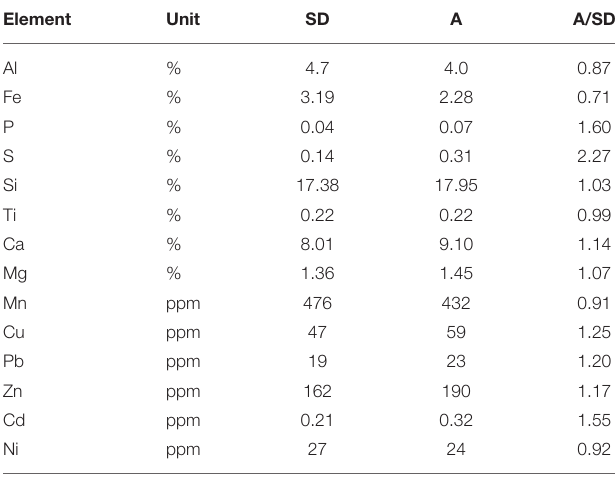
TABLE 2 | The elemental composition of the trace metals from the SD and A treatments.